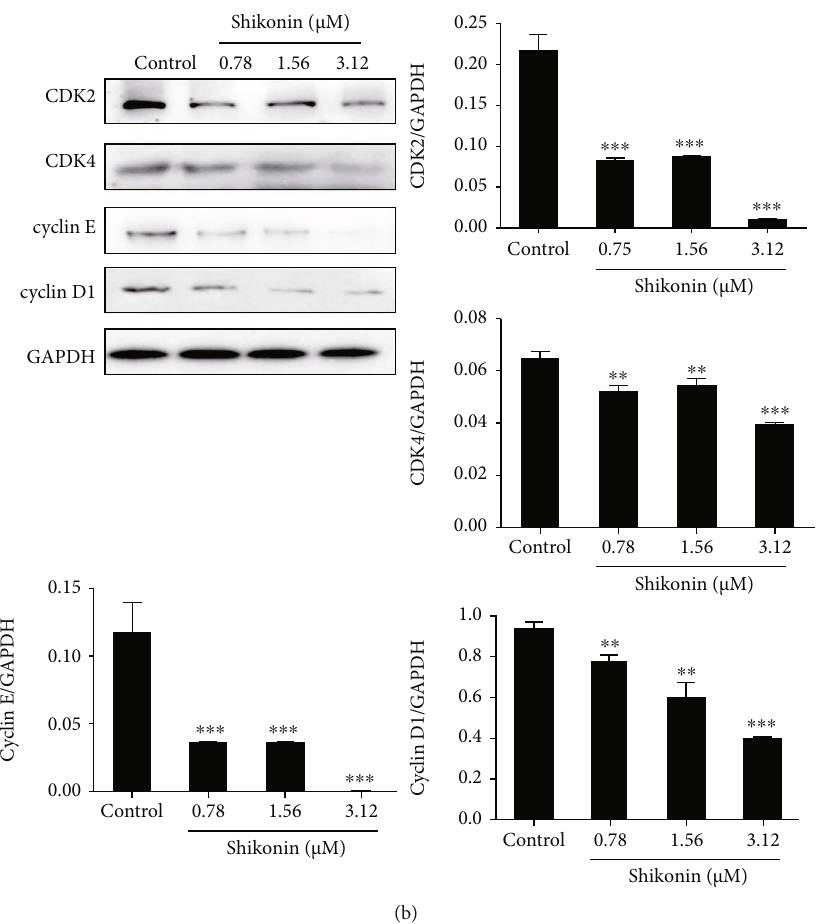
Figure 5: E ff ect of shikonin on molecules of cell apoptosis and cycle-related signaling. (a) Protein levels of XIAP and cleaved caspases 3 and 9 in H1299 cells treated with shikonin (0, 0.78, 1.56, and 3.12 μ M) for 48h were examined by western blot assay. (b) The protein levels of CDK2, CDK4, cyclin E, and cyclin D1 in H1299 cells treated with shikonin (0, 0.78, 1.56, and 3.12 μ M) for 48h were examined by western blot assay. Data are presented as the mean ± standard errorof the mean ( n = 3 ). ∗ P < 0 : 05 , ∗∗ P < 0 : 01 , and ∗∗∗ P < 0 : 001 vs.